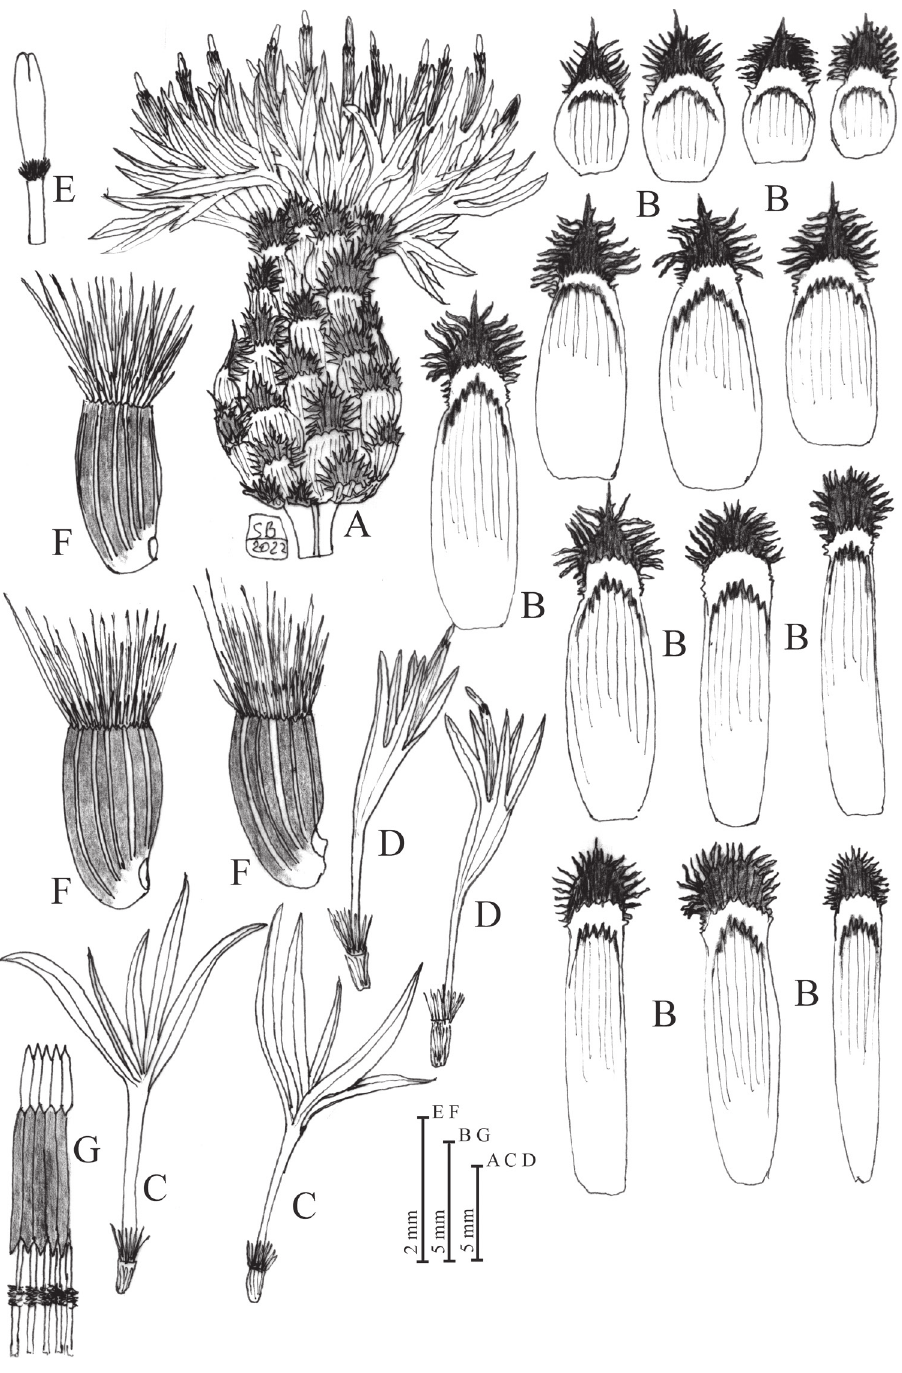
Figure 2. Centaurea lovricii sp. nov. A capitulum B phyllaries C outermost sterile florets D disc florets E stigma F achenes G stamens upper part. Drawn by Salvatore